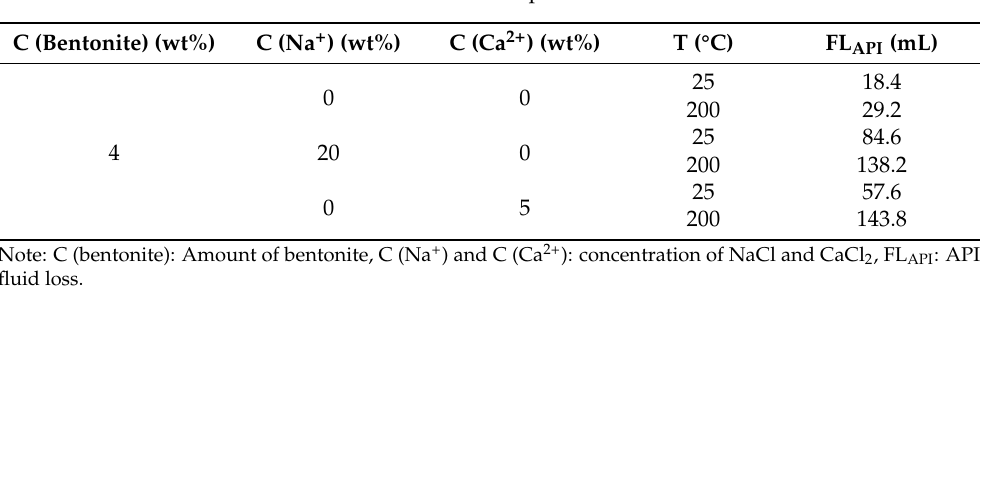
Figure 4. Filtration performance of DNDAP in the WBDF. ( a ) WBDF containing various concentrations of DNDAP and its filtration loss before and after aging at 200 ◦ C for 16 h. ( b ) Filtration performance of the WBDF supplemented with 2 wt% DNDAP at various temperatures. ( c ) The filter loss of DNDAP in Na-WBDF at different concentrations after aging at 200 ◦ C for 16 h. ( d ) The filter loss of DNDAP in Ca-WBDF at different concentrations after aging at 200 ◦ C for 16 h. Table 1. The Fluid Loss of the WBDF at Different Temperatures and Salt